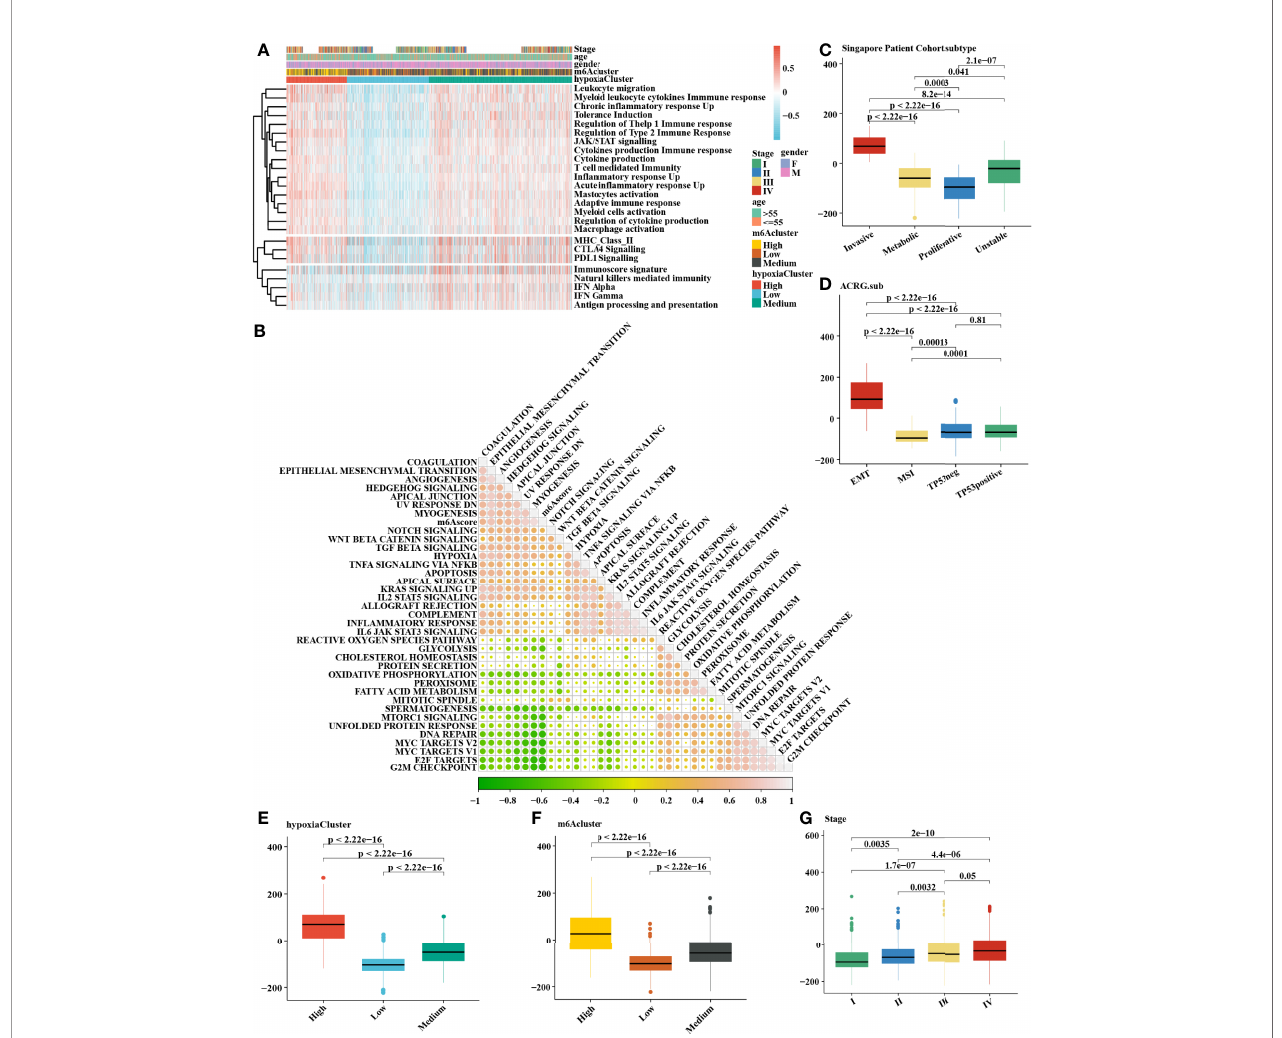
FIGURE 4 | Comprehensive analysis of distinct hypoxia status between 3 m6A methylation modi fi cation patterns. (A) The heatmap of gene set variation analysis (GSVA) was drawn on the basis of 25 immunity-related gene sets. m6Acluster high, leukocyte migration, myeloid leukocyte cytokine immune response, and mastocyte activation were mainly concentrated in the hypoxia-cluster high, which suggested hypoxia-cluster high might be in a immunosuppressed and stromal activation state. (B) The correlation analysis between m6Ascore and the known signatures. Orange indicates an R value > 0, blue indicates an R value < 0. (C – F) Calculation of the m6Ascore in different cohorts and the correlation in different subtypes, including (C) Singapore patient cohort (GSE15459 and GSE34942), (D) ACRG cohort (GSE62254), (E) hypoxiaCluster, (F) m6Acluster, (G) Stage. The upper and lower ends of the boxes meant the interquartile range of values. The lines in the boxes represented the median value. MSI, microsatellite instability. The Kruskal – Wallis test was used to compare the statistical difference between three gene